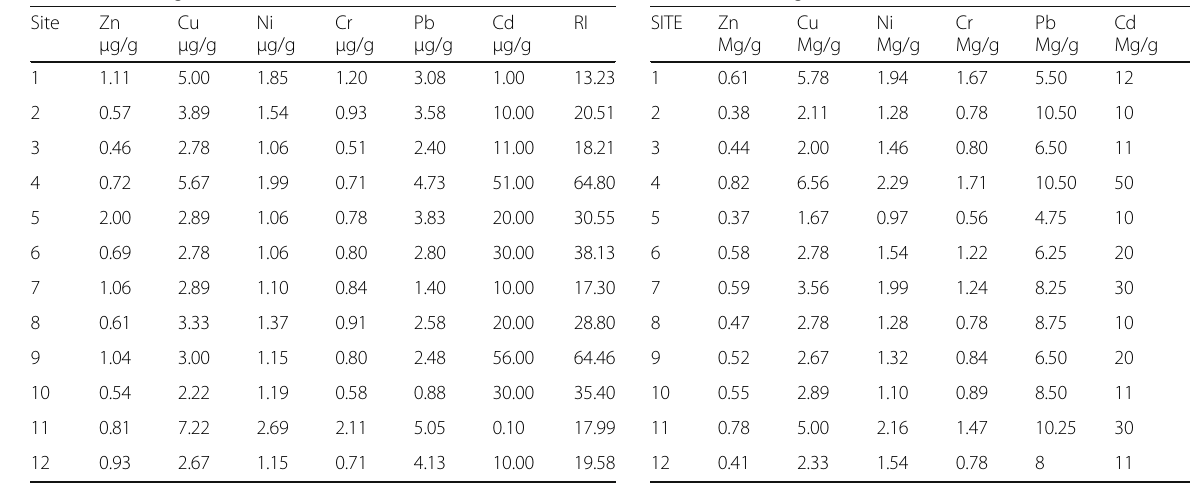
Table 15 Ecological risk factor